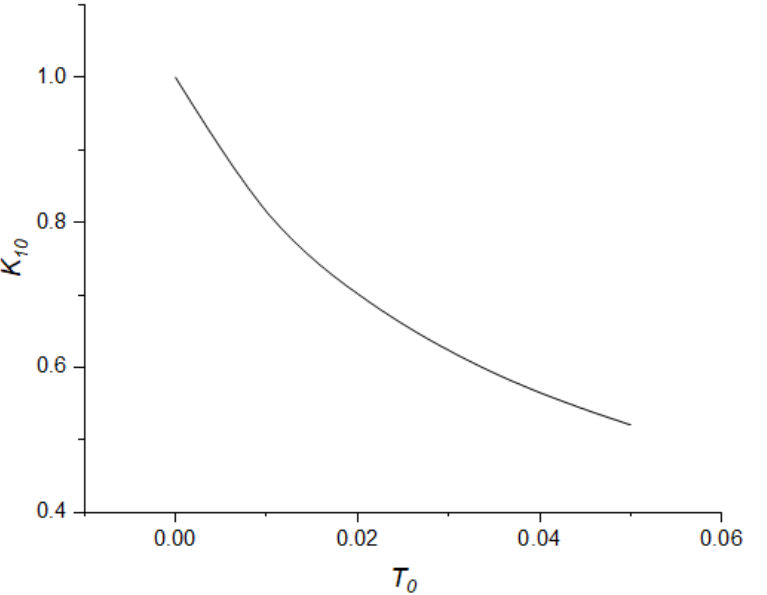
Figure 6. Variation of the total injectivity after the treatment divided by the initial value K 10 with the suspension injected volume T 0 . suspension injected volume T 0